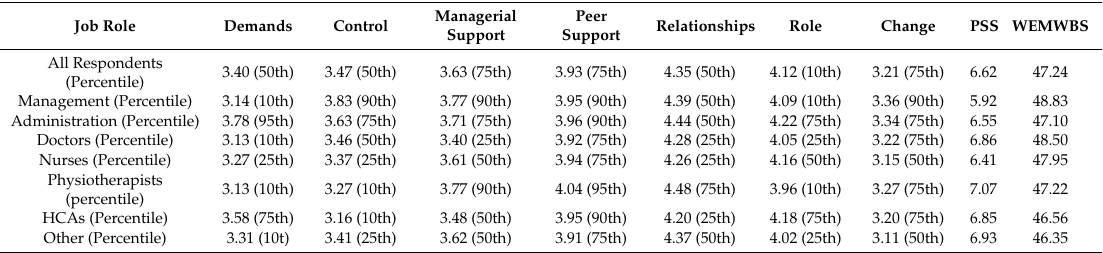
Table 2. Mean scoring on working conditions and total scoring on the Perceived Stress Scale and Warwick–Edinburgh Mental Wellbeing Scale (WEMWBS).